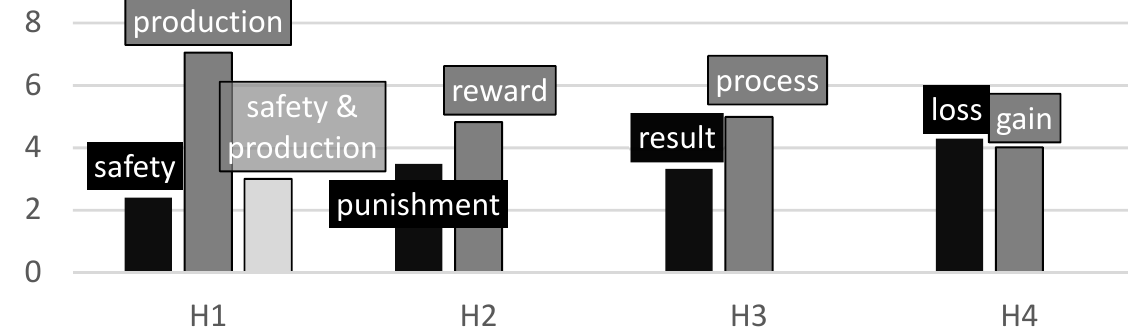
Figure 2. Average number of rule violations under the conditions, sorted by Hypotheses H1-H4 for main effects. No main effect was found for audit consequence ( F ( 1496 ) = 2.44, p = 0.12, eta 2 < 0.01),